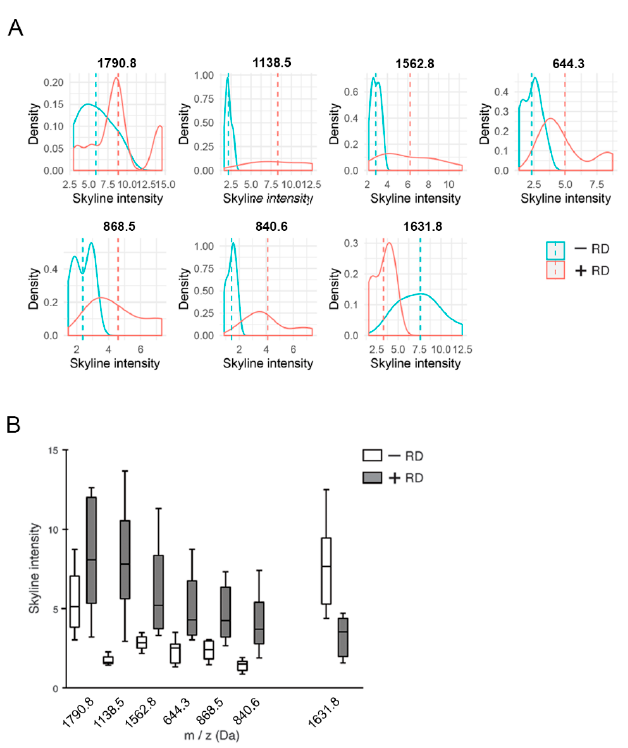
Figure 4. Examples of peptide distribution within groups of patients with (+RD) and without recurrent disease ( − RD) by mass spectrometry intensity. ( A ) Density plot of skyline intensities over a continuous interval. Dashed lines indicate the distributions’ mean values. ( B ) Boxplot.